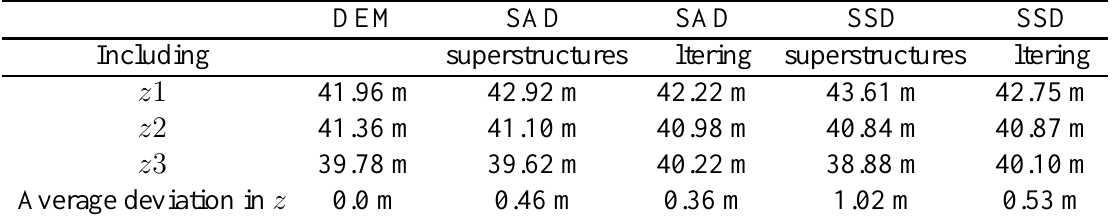
Table 4. Comparing the modeling results obtained with the SAD and SSD scores using facets including superstructures with and without the filtering process.